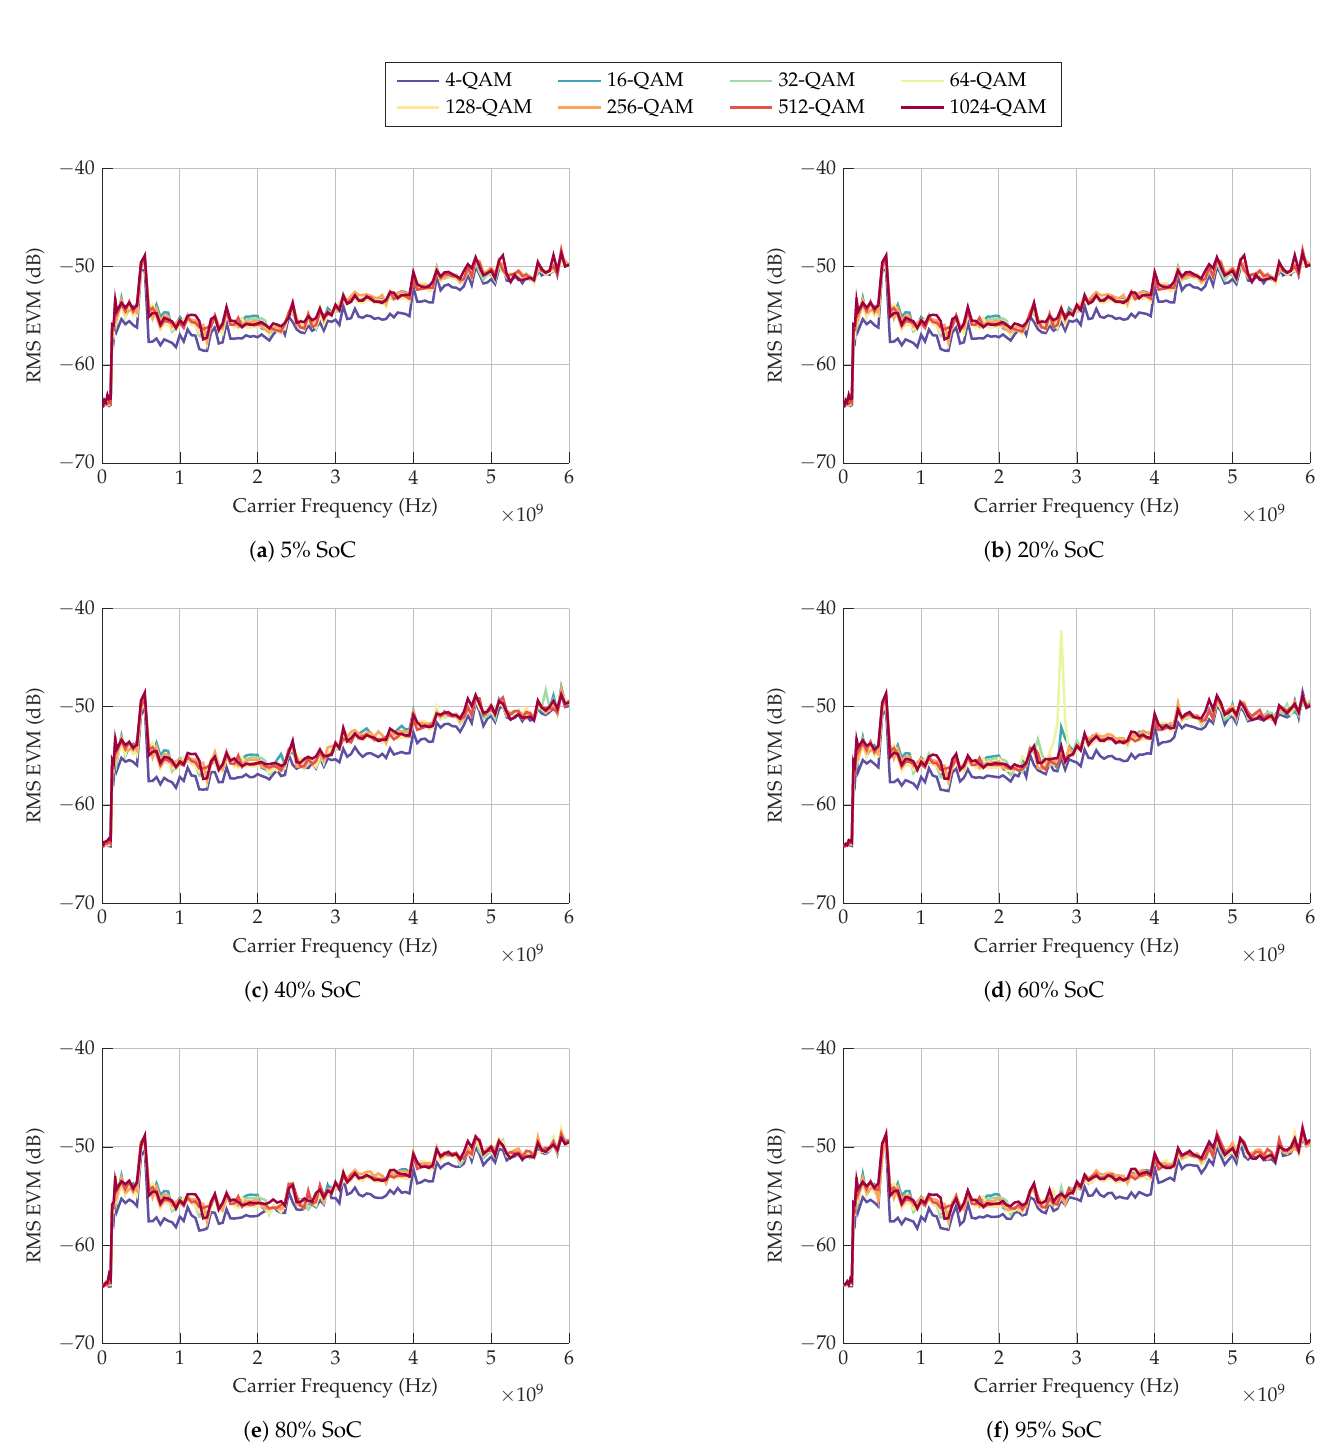
Figure A3. RMS EVM for QAM-signals transmitted with a peak output power of Li-ion cell at various SoC. Each QAM order is represented in a different